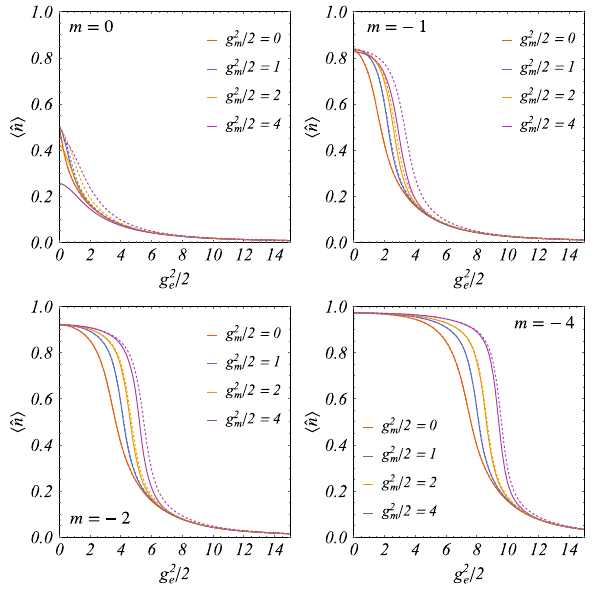
20. Particle density as a function of the electric coupling g for different values of the magnetic coupling g e panels represent different bare masses. Solid lines are the S ¼ 1 results; dashed lines are the S ¼ 2